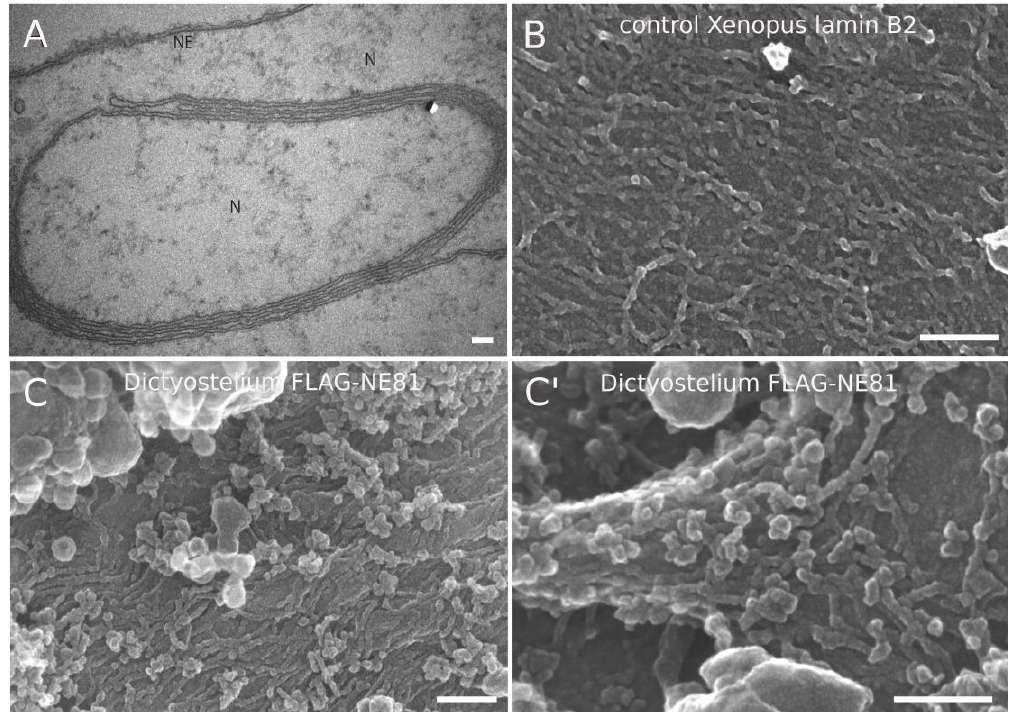
Figure 1. Filamentous structures at intranuclear membrane stacks obtained upon expression of FLAG-NE81 in Xenopus oocytes. ( A ) TEM image showing intranuclear membrane stacks elicited through FLAG-NE81 expression. ( B , C , C′ ) Field-emission (fe)SEM image showing Xenopus lamin B2 filaments ( B ) and Dictyostelium FLAG-NE81 filaments ( C , C′ ) associated with intranuclear membrane stacks. Scale bars = 100 nm.